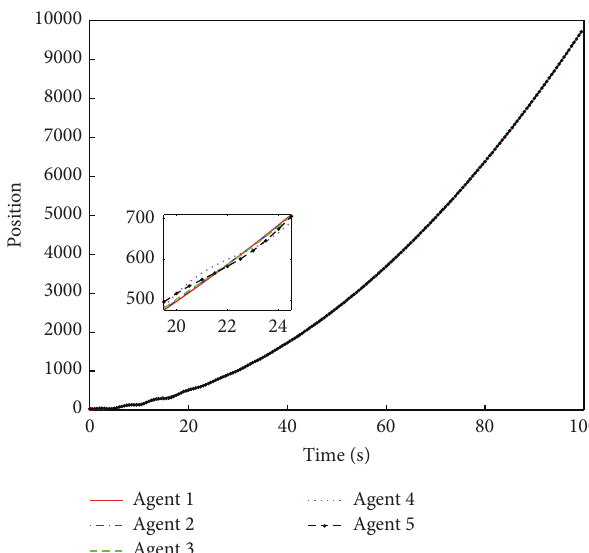
Figure 4: Consensus of position for second order system.